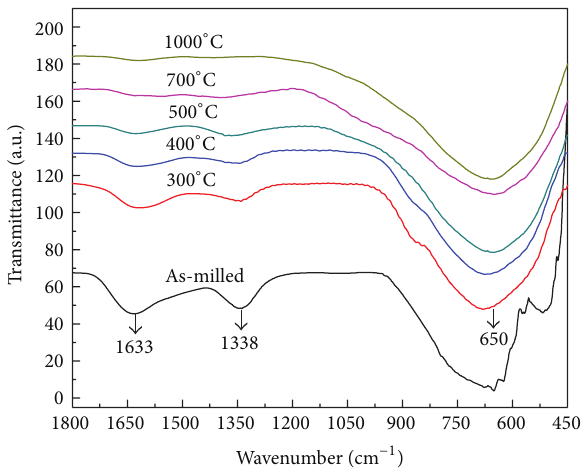
Figure 5: X-ray diffraction diagrams of as-milled (K 0.5 Na 0.5 )NbO 3 and samples calcined at 300, 400, 500, 700, and 1000 ∘ C for 3h. Figure 6: FTIR spectra of as-milled (K 0.5 Na 0.5 )NbO 3 and samples calcined at 300, 400, 500, 700, and 1000 ∘ C for 3